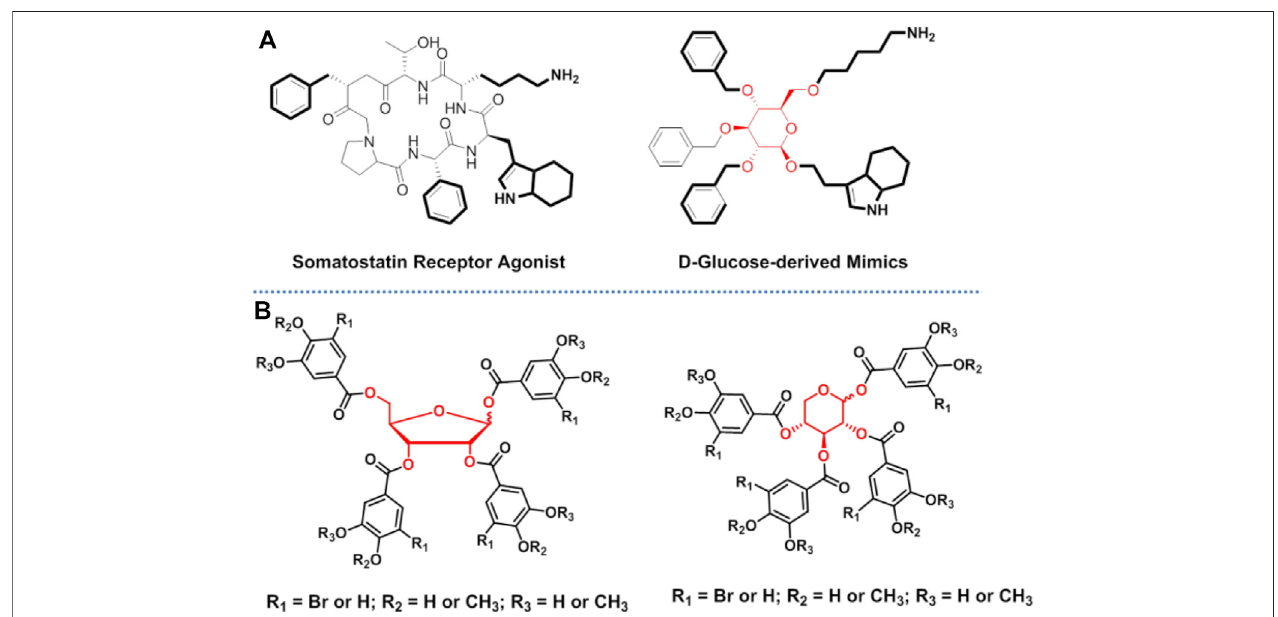
FIGURE5| Carbohydrates usedasscaffoldsindrugdiscovery: (A) glucose wasused tomimic thebackboneofpeptides; and (B) carbohydrateswereused inthe screening of PTP1B inhibitors.